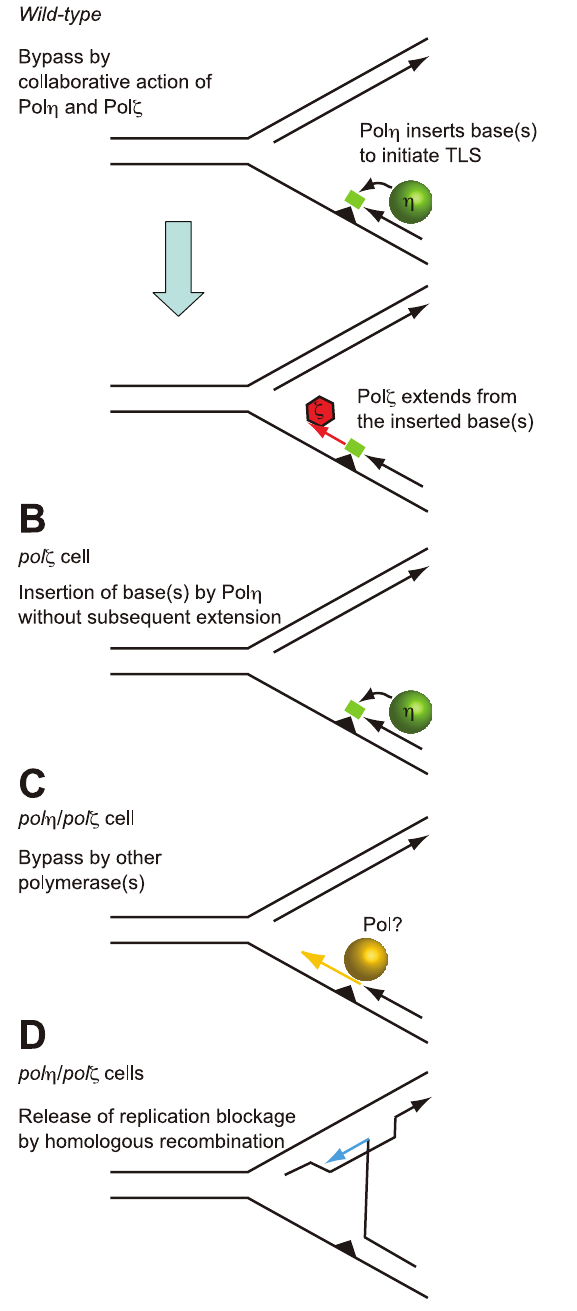
Figure 7. Model for the sequential action of Pol g and Pol f in wild-type , pol f , and pol g /pol f clones. (A) The two step-model for TLS. In wild-type cells, Pol g is efficiently recruited to a replication blockage at a DNA lesion (green circle) on a template strand and inserts 1 , 2 base(s) (green box) to bypass the lesion (filled triangle). Pol f further extends from these inserted base(s) (red arrow) before replicative DNA polymerases can take over from Pol f . (B) In pol f cells, after Pol g inserts nucleotides opposite to DNA lesions, no other polymerases can effectively extend DNA synthesis for subsequent DNA synthesis by replicative polymerases. (C) In pol g /pol f cells, other TLS polymerases carry out TLS. (D) The replication blockage may be released by a template switch to the intact sister chromatid using the HR